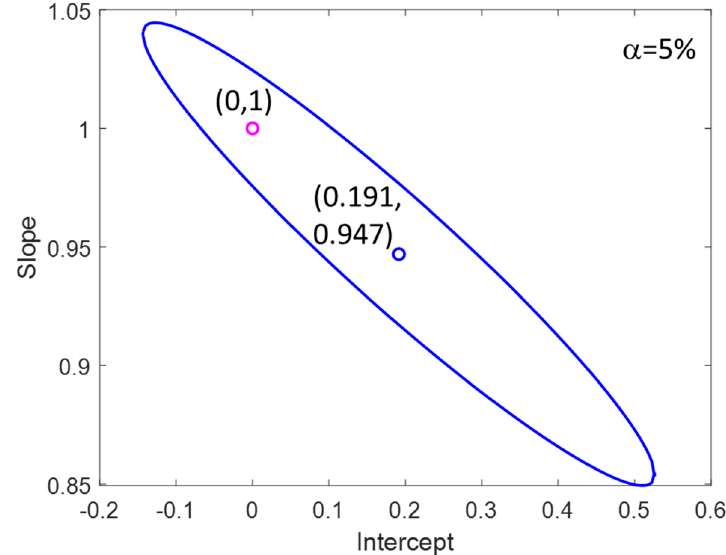
Figure 8. Joint confidence interval for the intercept and the slope of the comparison between the declared and predicted % of proteins.